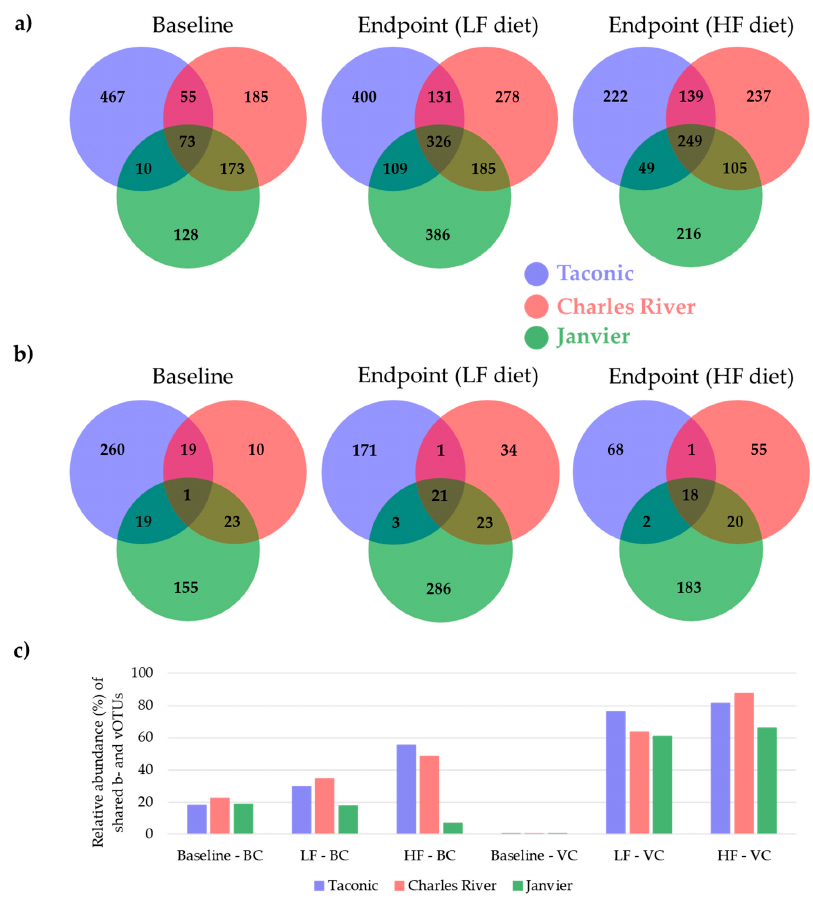
Figure 5. Venn diagrams illustrating the number of shared caecal ( a ) bacterial and ( b ) viral OTUs (b- and vOTU’s) amongst mice purchased from three vendors at baseline (five weeks old) and endpoint (18 weeks old) on either high-fat (HF) or low-fat (LF) diet. The numbers inside the Venn diagram indicate the amount of shared OTUs. ( c ) Bar plot illustrating the sum of the relative abundance of the shared b- and vOTUs from baseline to endpoint. BC = Bacterial community, VC = viral